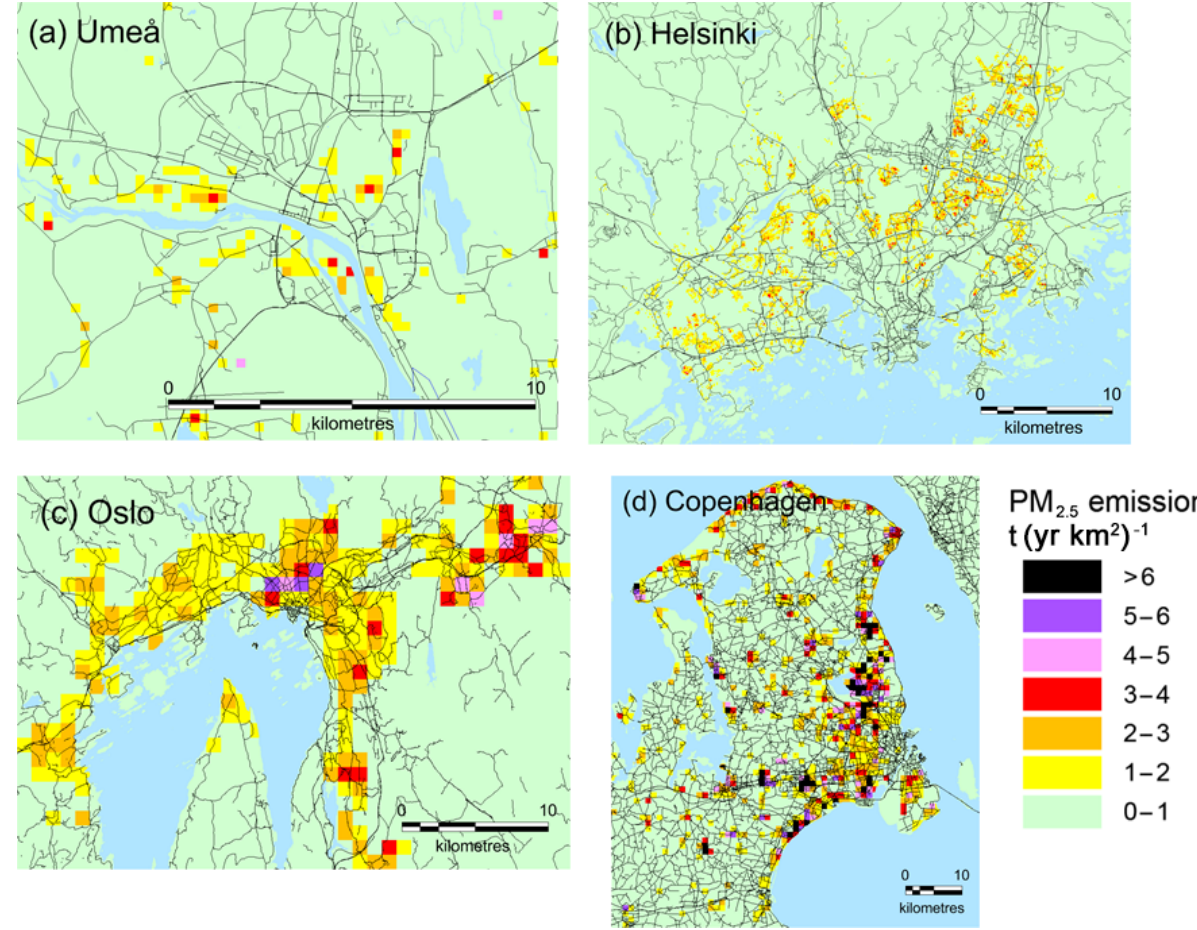
Figure 5. The predicted emissions of PM 2 . 5 originating from RWC in Umeå (a) , Helsinki (b) , Oslo (c) and Copenhagen (d) . The spatial resolution is 250 × 250m 2 for Umeå, 100 × 100m 2 for Helsinki, and 1 × 1km 2 for Oslo and Copenhagen. The unit is t ( yrkm 2 ) − 1 for all the domains. The sea and inland water areas have been presented using a light blue colour. The results represent the year 2011 for Umeå, 2013 for Helsinki and Oslo, and 2014 for Copenhagen. The physical scales of the domains have also been indicated. © OpenStreetMap contributors 2019. Distributed under a Creative Commons BY-SA